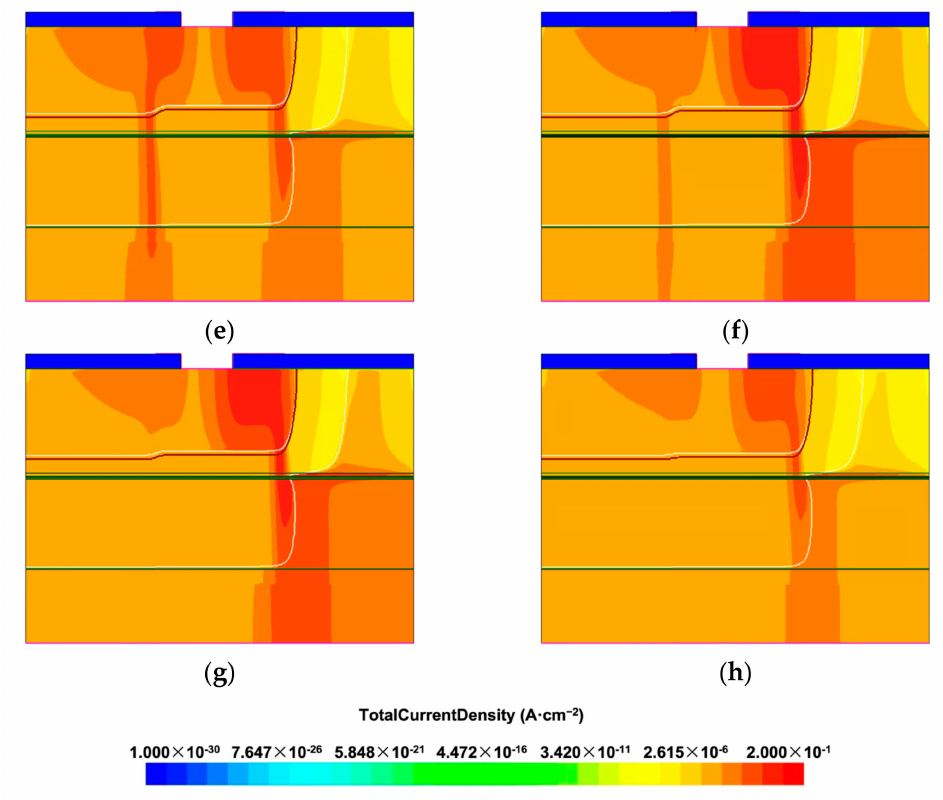
Figure 2. TCAD simulation of current density at breakdown voltage of devices with different AGR depth: ( a ) AGR depth of 2.23 µ m; ( b ) AGR depth of 2.44 µ m; ( c ) AGR depth of 2.61 µ m; ( d ) AGR depth of 2.73 µ m; ( e ) AGR depth of 2.77 µ m; ( f ) AGR depth of 2.81 µ m; ( g ) AGR depth of 2.87 µ m; ( h ) AGR depth of 2.95 µ m. The diffusion depth of active region is 3.04 µ m. The color bar for ( a – h ) is displayed below the figures. Two blue rectangles on the top of ( a – h ) represent the SiN passivation layer, and the contact is placed between